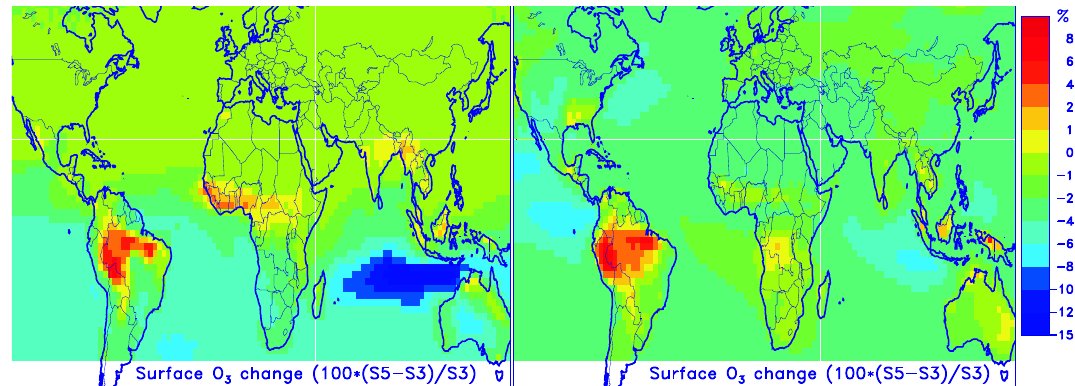
Fig. 5. Calculated impact on surface O 3 concentrations of the LIM0 mechanism update in January and July 2005.